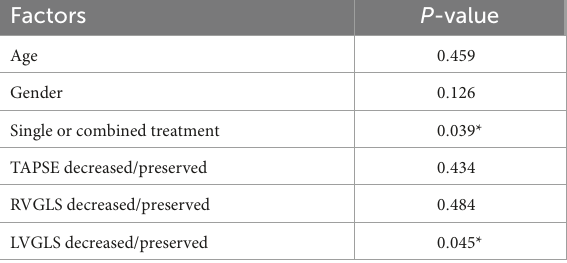
TABLE 5 Cox regression analysis for survival